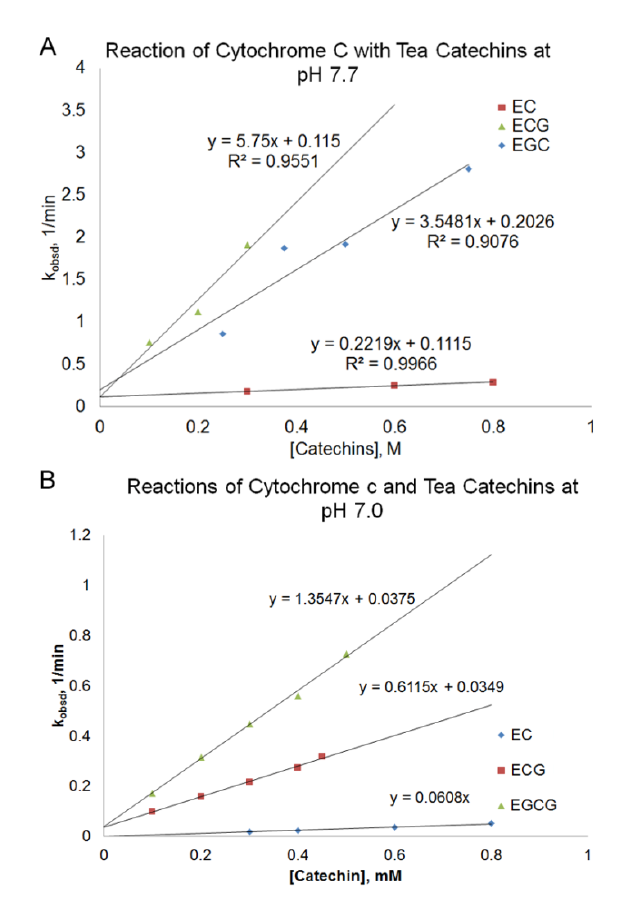
Figure 3. Plot of pseudo-first order rate constant, k for the reaction of different green tea catechins with cytochrome c at pH 7.7 ( A ) and pH 7.0 ( B